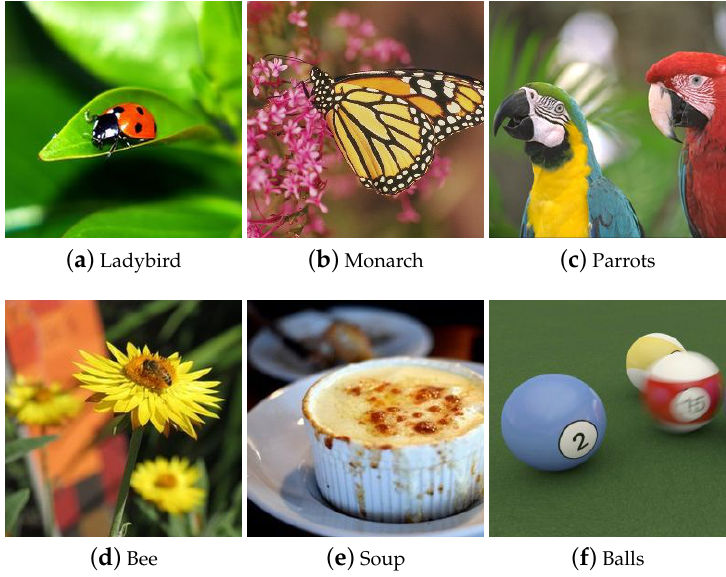
Figure 5. The benchmark images used in the experiments.